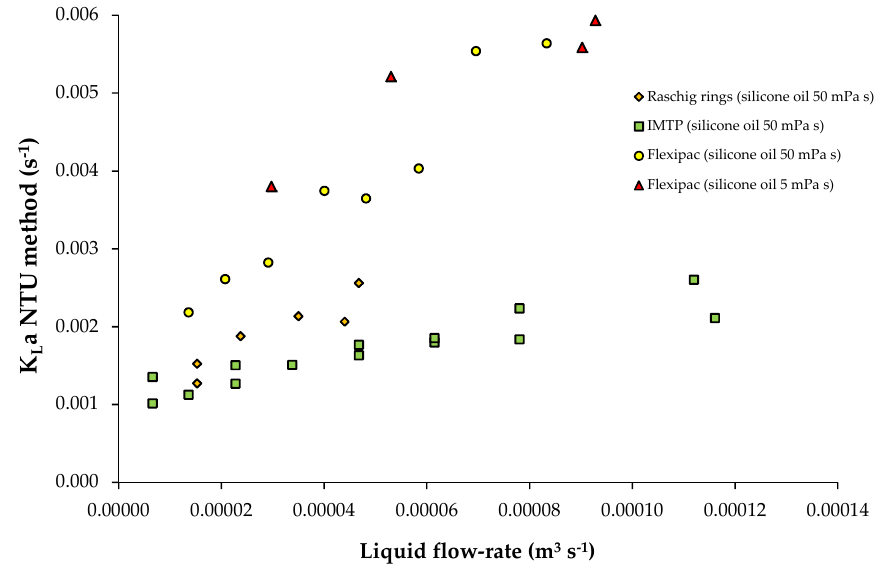
Figure 9. K L a versus the liquid flow-rate (calculated from Reference [10], (V = 1.13 × 10 −2 m 3 ; T = 25 °C).